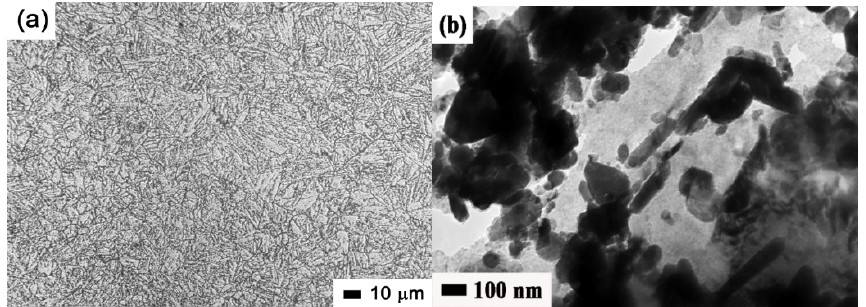
Figure 1. As-received microstructure: ( a ) optical and ( b ) TEM